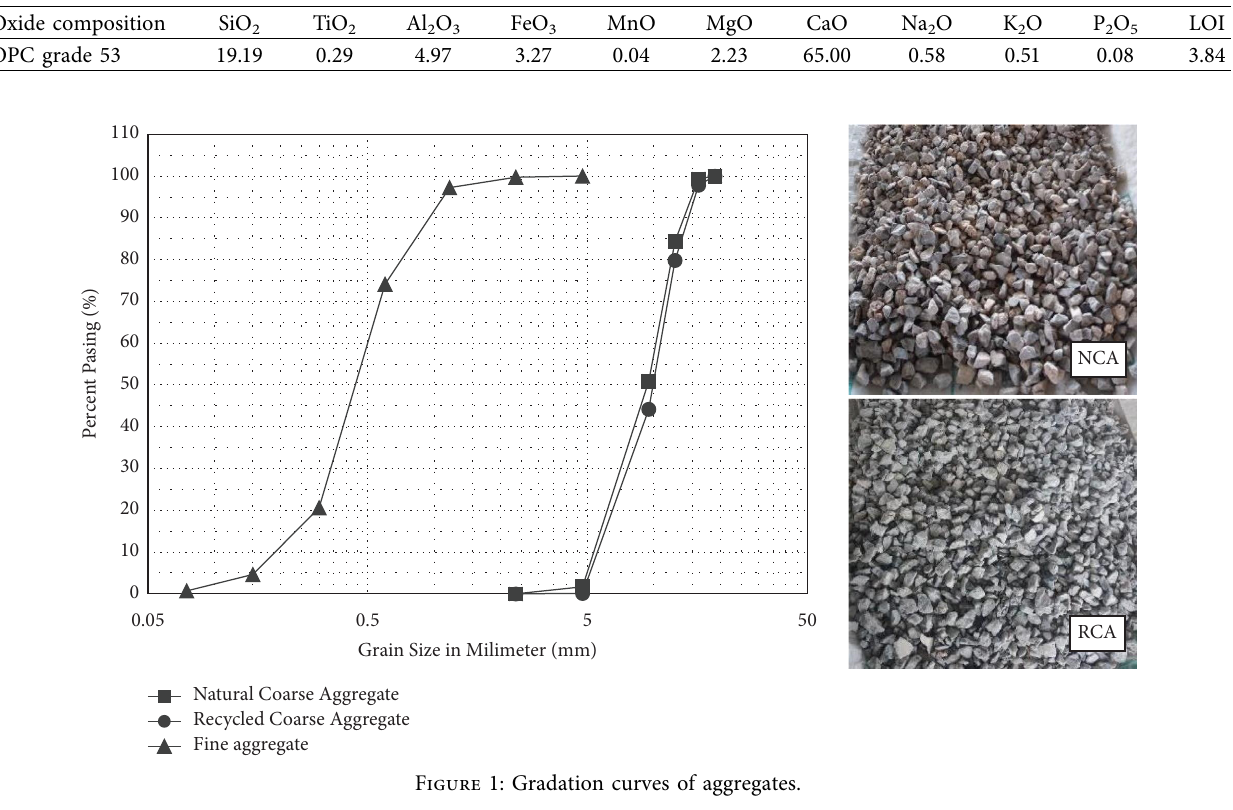
Table 2: Chemical properties of cement.